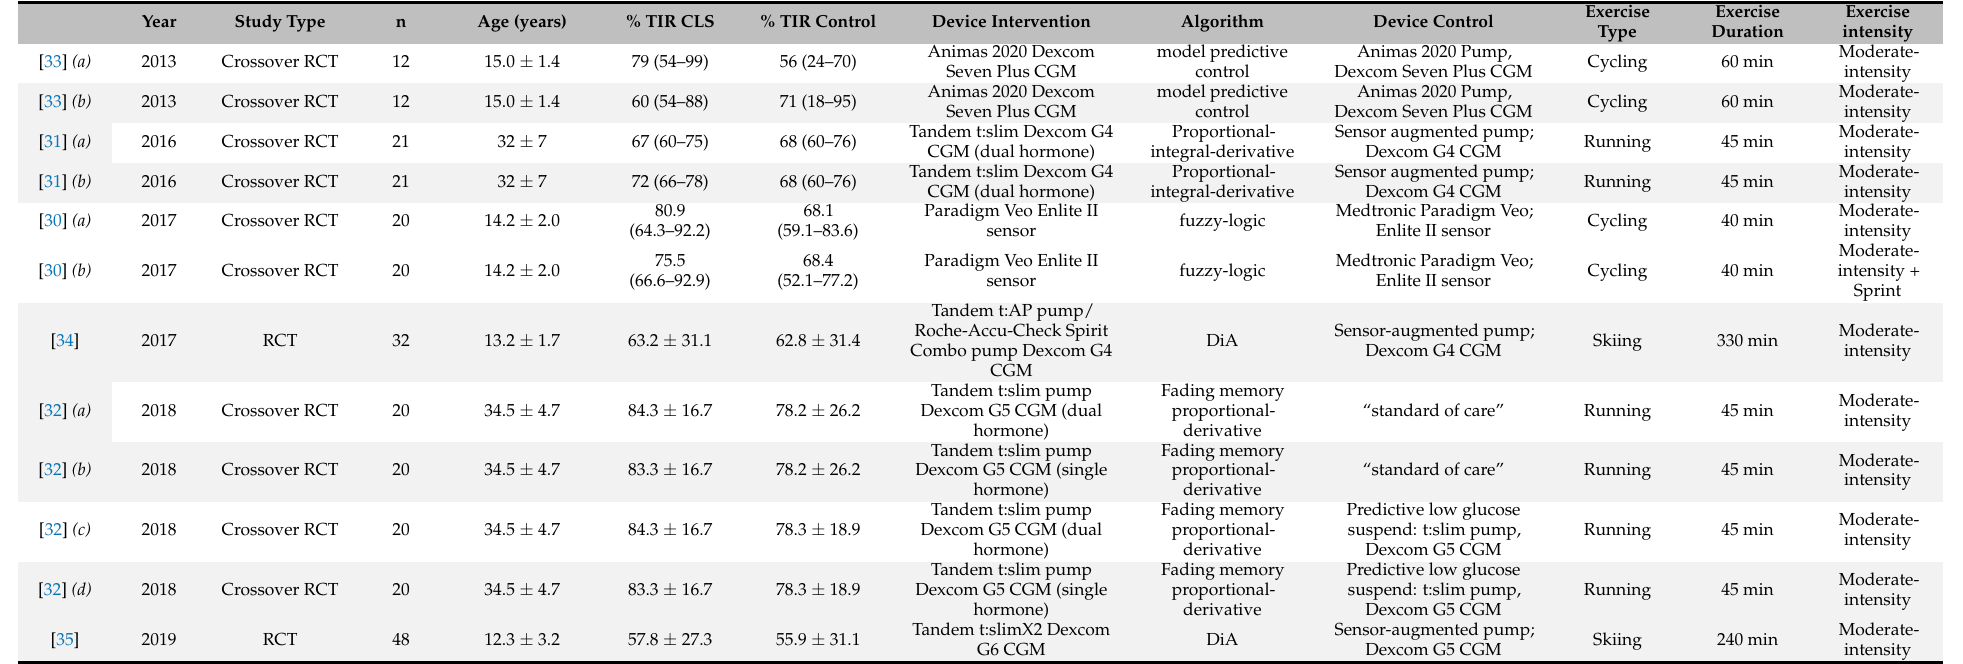
Table 1. Generals study